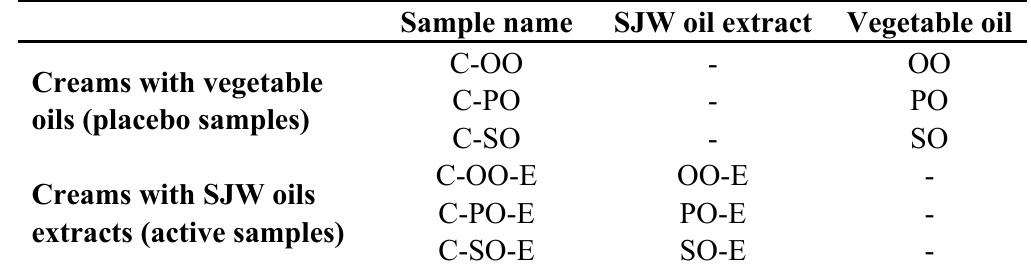
Table 5. O/W creams prepared with different vegetable oils and corresponding SWJ oil